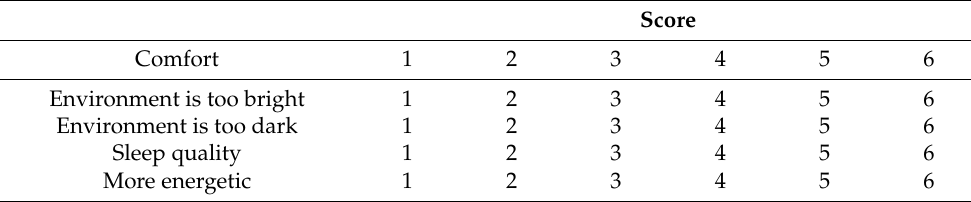
Table 2. Epworth Sleepiness Scale.